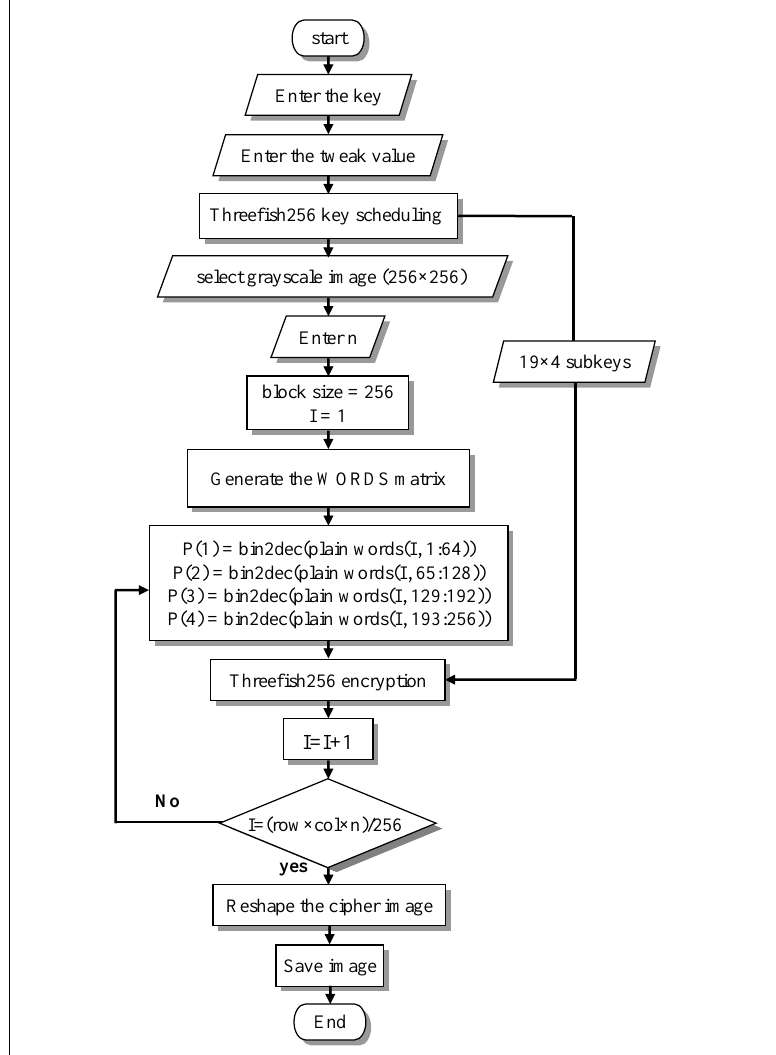
Figure 4. The dataflow of proposed